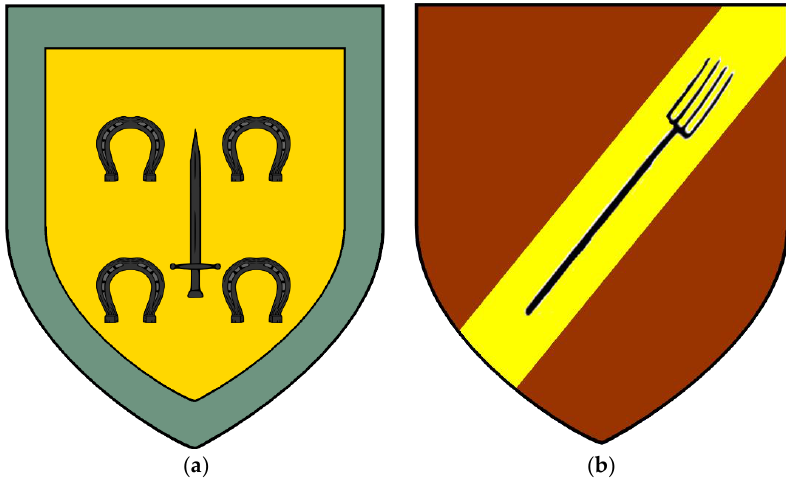
Figure 7. Canting arms are numerous in the world of Westeros: ( a ) The forged products of House Ironsmith; ( b ) The pitchfork of House Haigh (hay).